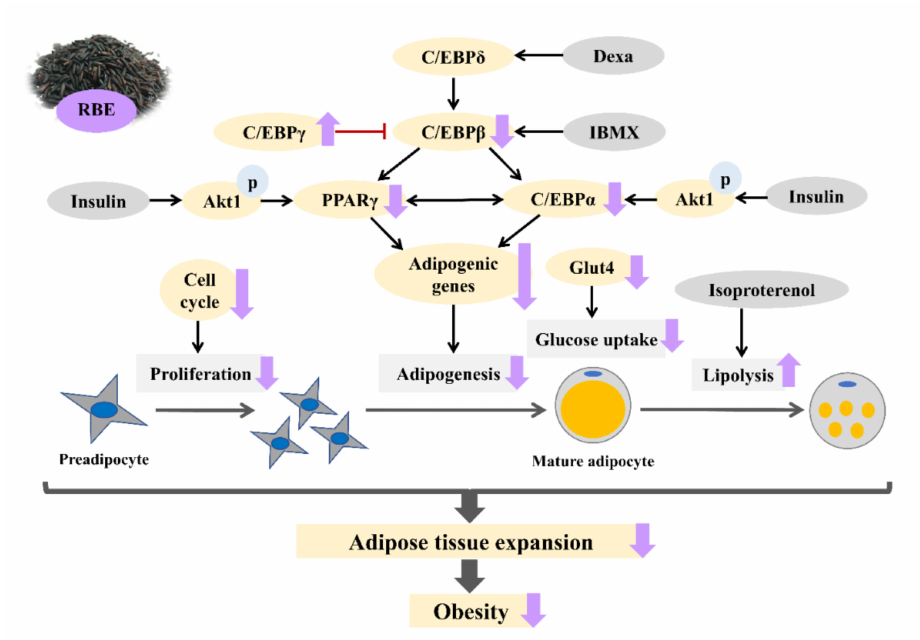
Figure 9. Schematic summary of the inhibitory e ff ect of Riceberry rice extract (RBE) on cell proliferation and di ff erentiation in 3T3-L1 adipocytes. RBE suppressed preadipocyte proliferation through inducing cell cycle arrest. RBE downregulated adipogenic transcription factors and their target genes, leading to inhibit adipogenesis and reduce glucose uptake. In addition, RBE enhanced isoproterenol-induced lipolysis in mature